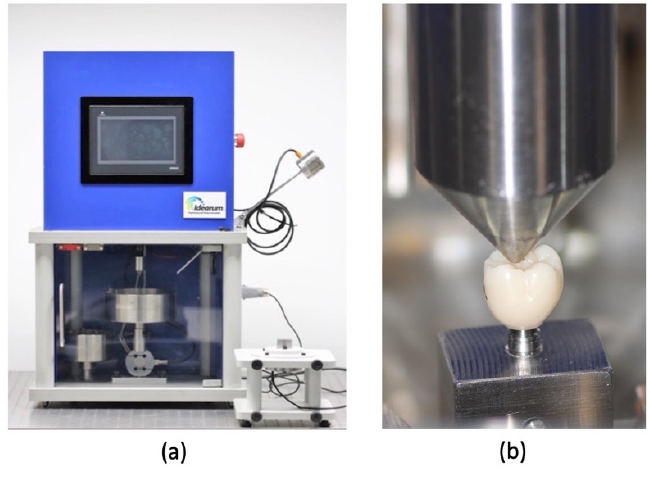
Figure 3. ( a ) CS ® Dental Testing Machine; ( b ) simulated compressive force movement. The types of fracture were also evaluated according to Burke’s classification across the entire sample, as described in Table 2.